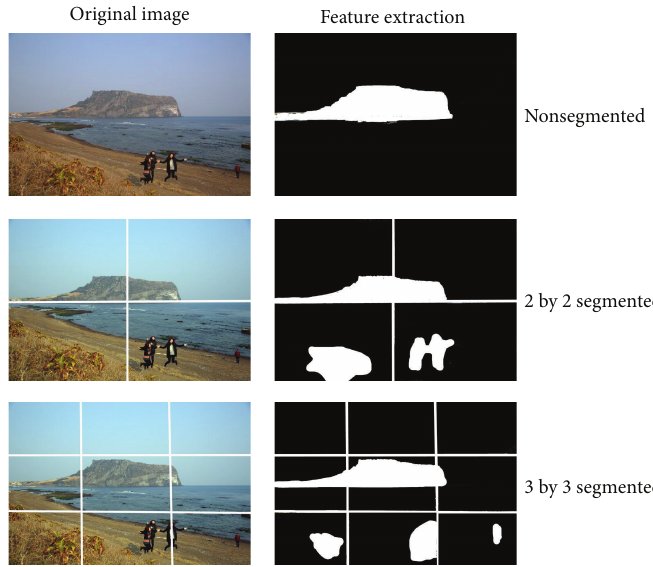
Figure 5: An illustration of objects extracted from segmented